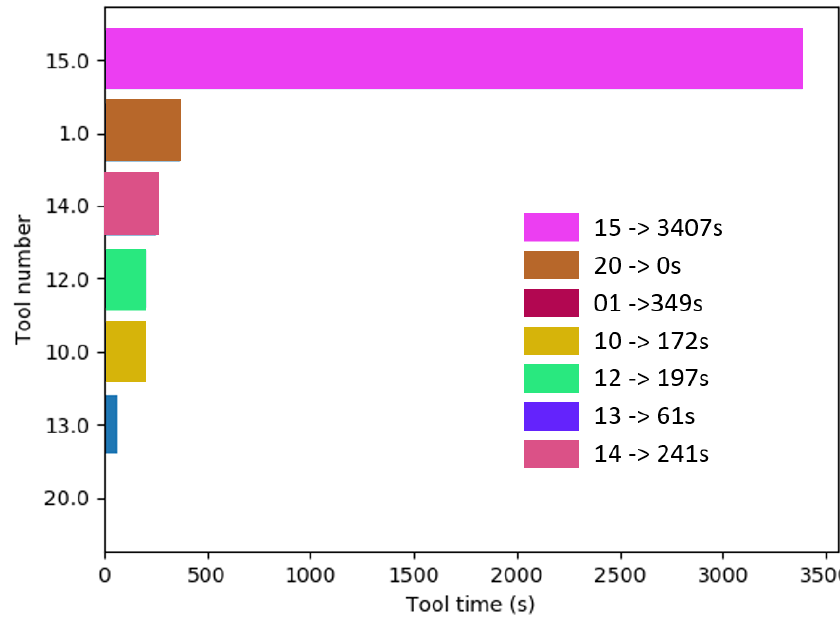
Figure 4. Time of use per tool(s).